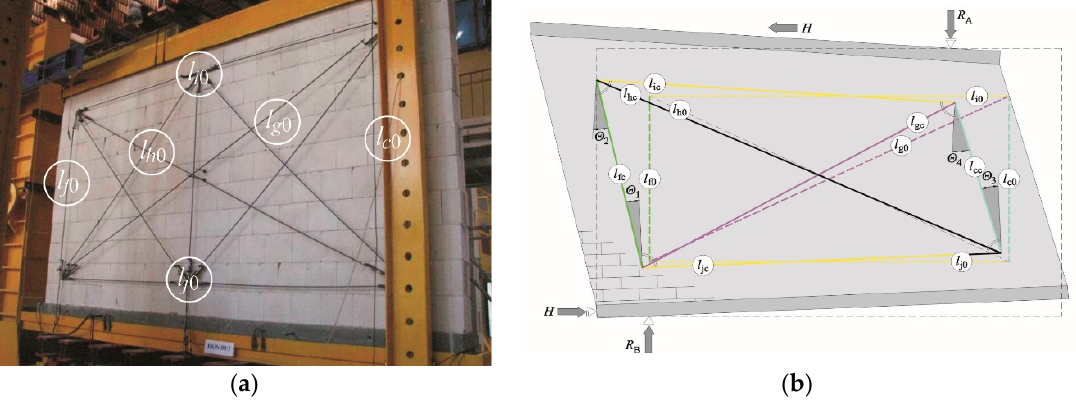
Figure 6. Frame system for measuring strain and deformation angle: (a) a wall made of calcium silicate units and (b) determining measurement bases and partial strain angles.